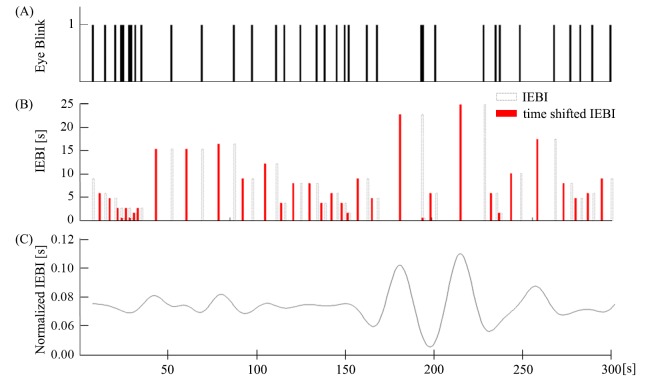
Pre-processing of eye blink data.(A) Raster plot of eye blinks. (B) IEBI plot aligned to the center time point (red bar) as a representative sample of IEBIs. (C) Continuous plot of IEBI filtered with a Gaussian kernel after normalization to the average IEBI.